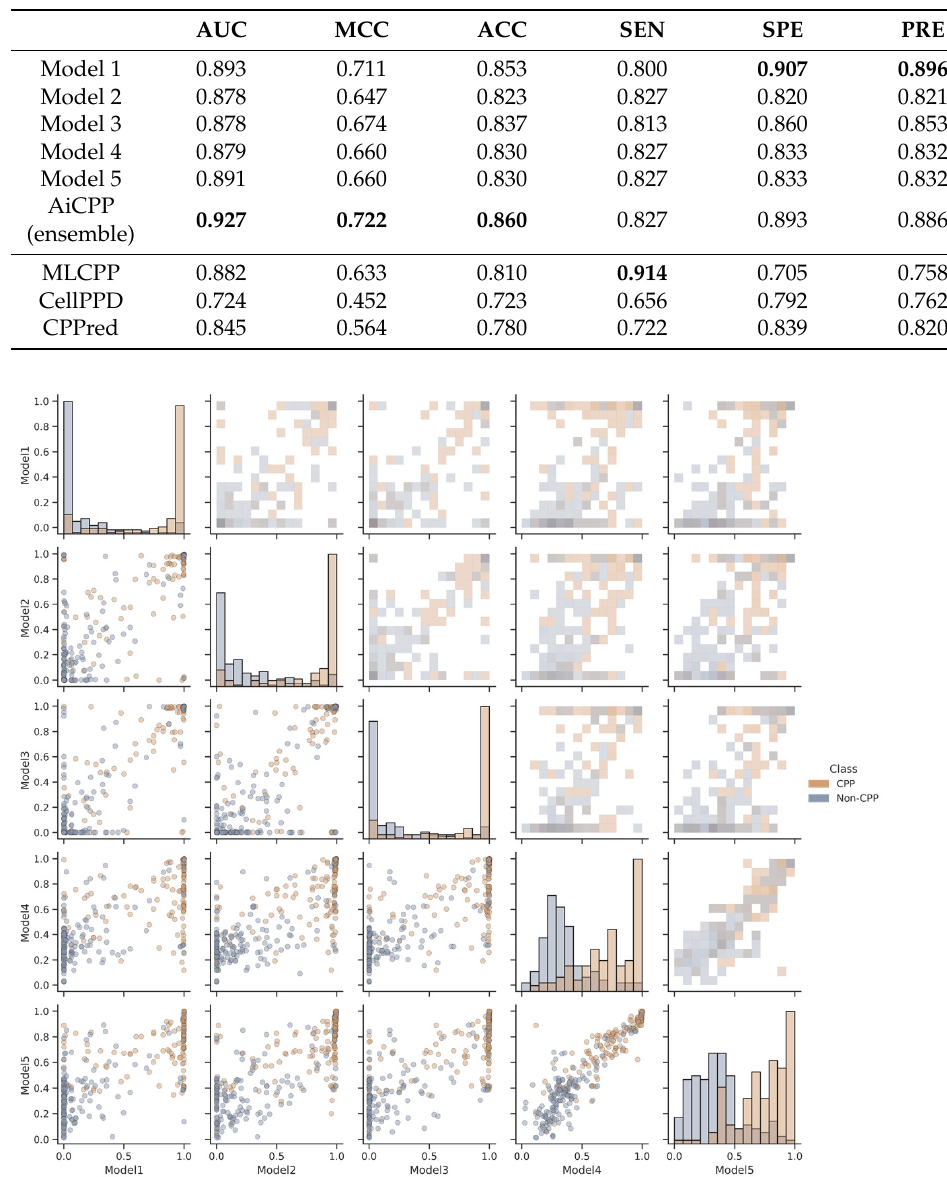
Figure 5. Pair plot of the AiCPP models’ correlation. Each dot in the two-dimensional scatterplot represents a peptide, either CPP (orange) or non-CPP (blue), and compares the predicted values of each model.